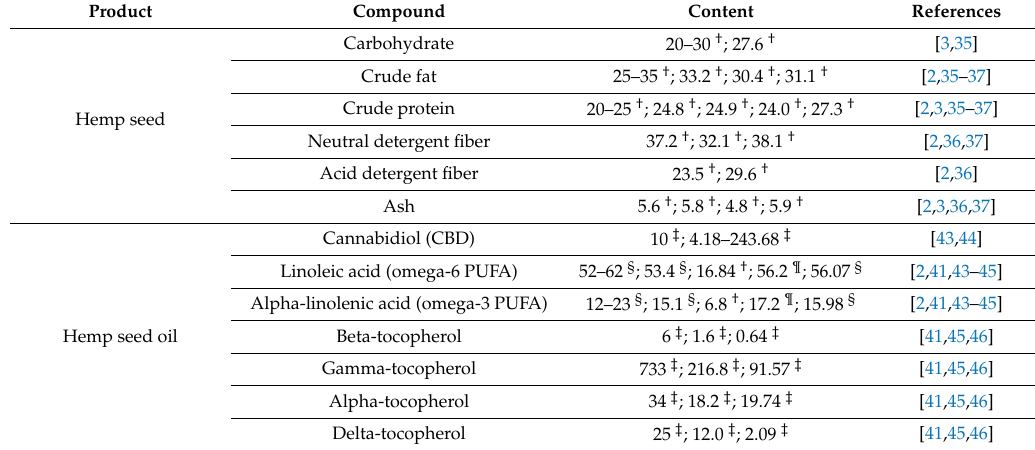
Table 1. Important major and minor constituents of hemp seed and hemp seed